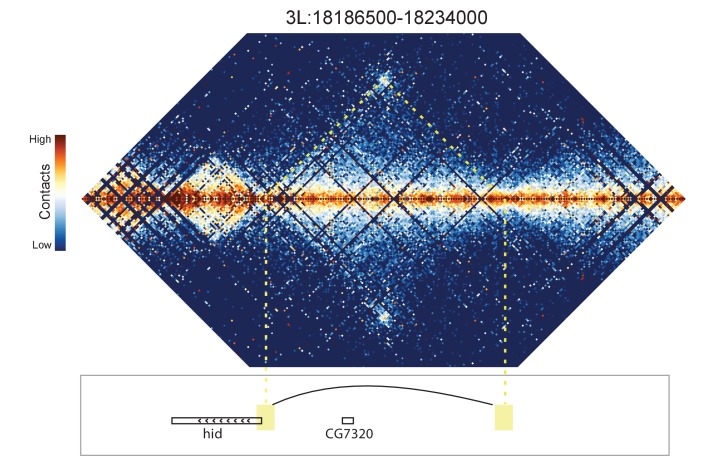
Hi-C map for the locus spanning 3L:18186500-18234000.A looping interaction is observed between the 5' end of the hid gene and an upstream intergenic region.